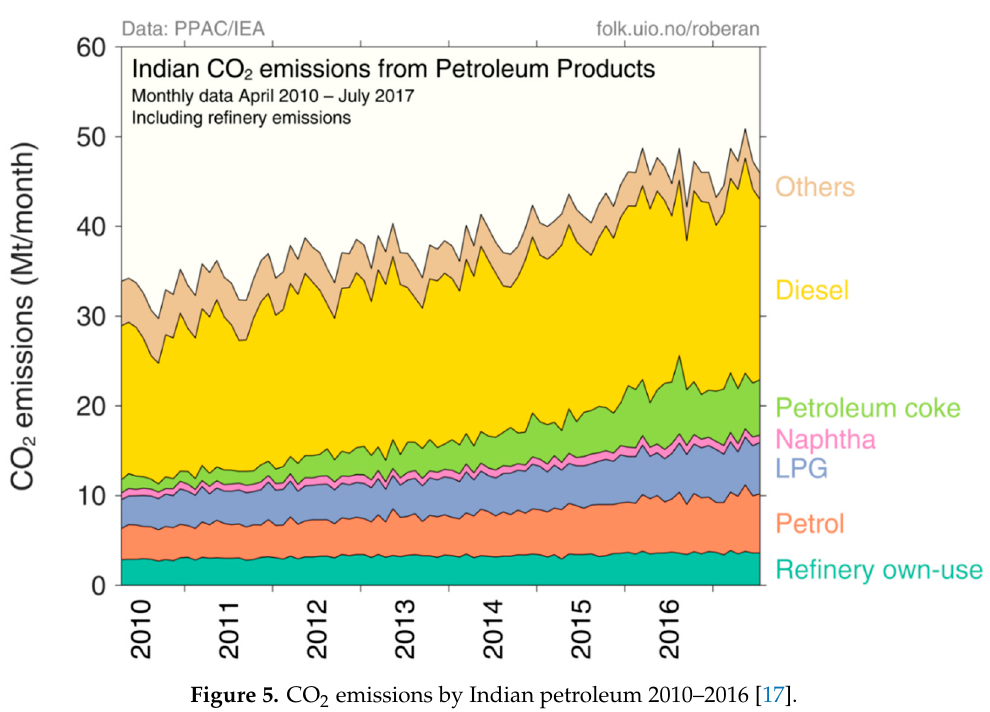
Energies 2020 , 13 , x FOR PEER REVIEW Figure 5. CO 2 emissions by Indian petroleum 2010–2016 [17]. Figure 5. CO 2 emissions by Indian petroleum 2010–2016 [17].